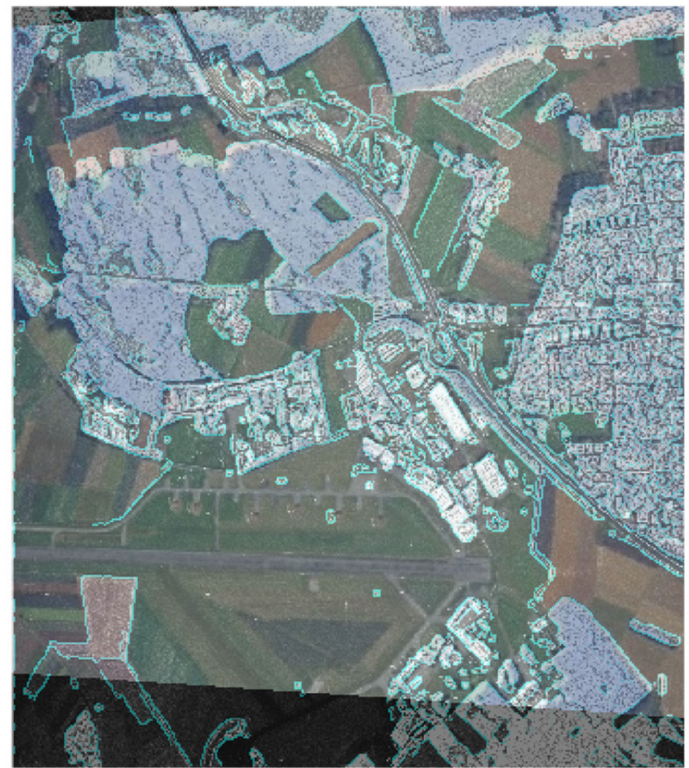
Figure 10. The result of the fusion of optical and radar